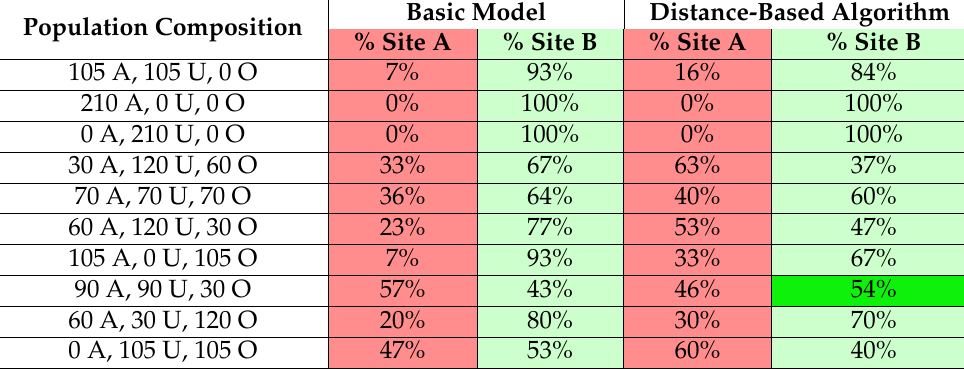
Figure 5. The emergence of collective decision: ( a ) when robots follow the basic behavioral model, and ( b ) when robots classify themselves using the distance-based algorithm. We simulate a swarm of the following: 70 objective, 70 underestimating, and 70 overestimating robots, where Errors in measurements can occur at both sites A and B. Table 4. Comparing the accuracy of consensus accuracy when using the basic behavioral model vs. the distance-based algorithm for different swarm compositions. Errors in measurements can occur at both sites A and